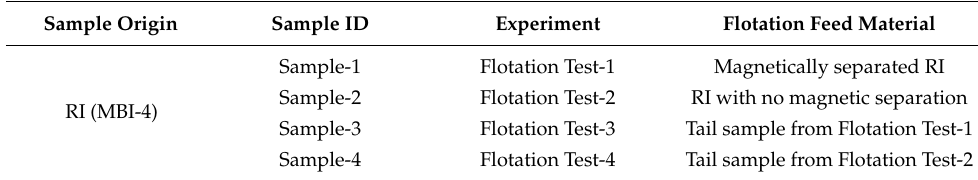
Table 1. Identification of samples for flotation testing in the current